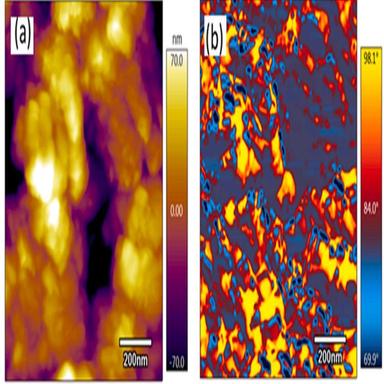
(a) Surface topography of ZNF(HP) sample (1 µm size region) (b) MFM phase contrast of ZNF(HP) corresponding to the topography region.